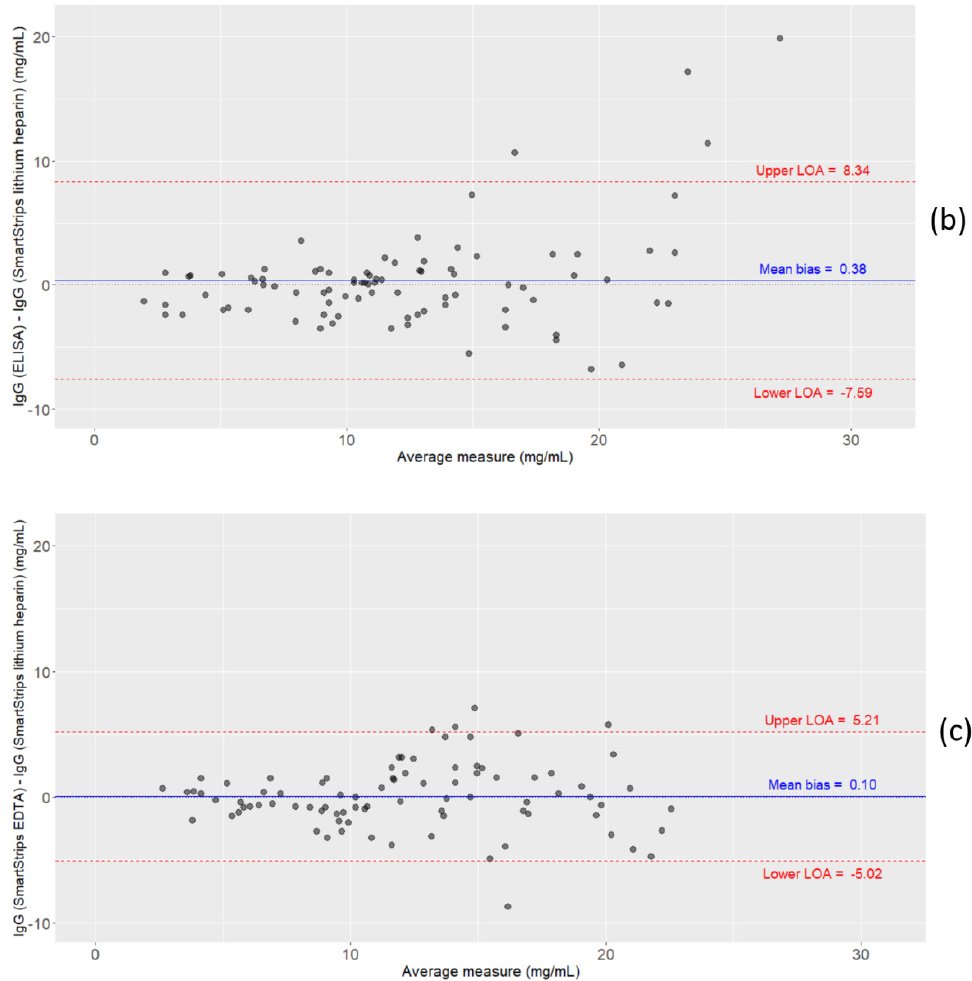
Figure 3. Bland-Altman plots showing the level of agreement between serum IgG concentration (mg/mL) measured by ( a ) ELISA vs. the quick test (SmartStrips TM ) with EDTA ( n = 91), ( b ) ELISA vs. SmartStrips TM with lithium heparin ( n = 87), and ( c ) SmartStrips TM with EDTA vs. SmartStrips TM with lithium heparin ( n = 86). LOA = limit of agreement.